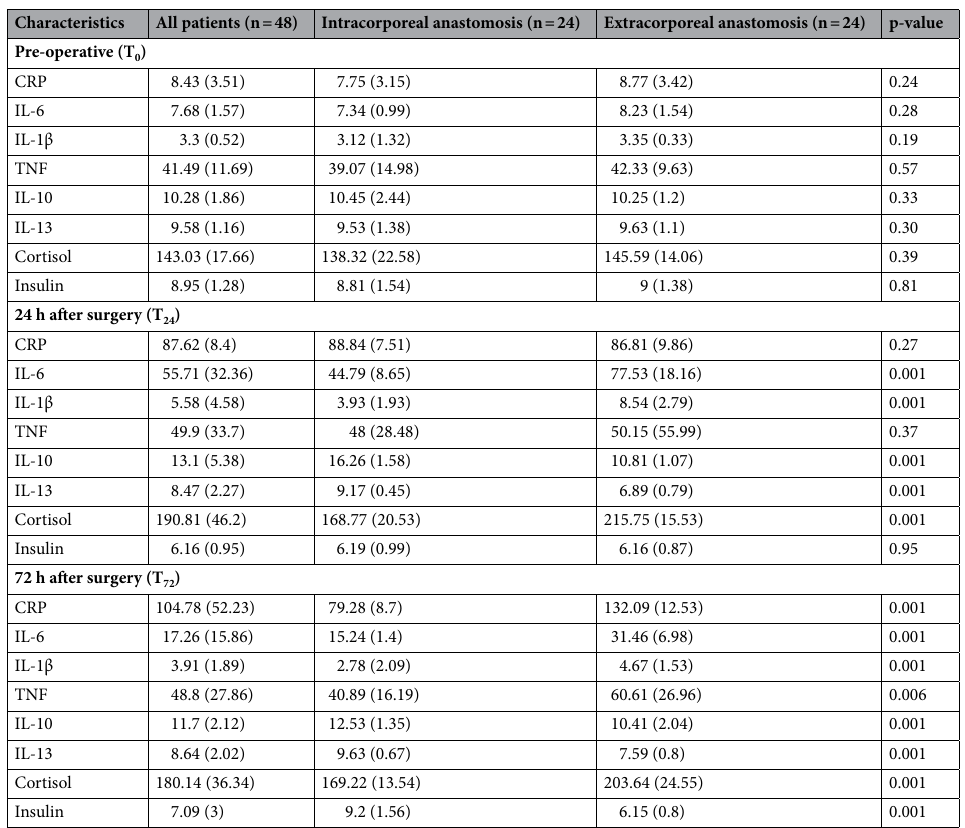
Table 4. Inflammatory mediators in patients without post-operative complications. Data were expressed as median (interquartile range). CRP C-reactive protein, TNF Tumor Necrosis Factor, IL